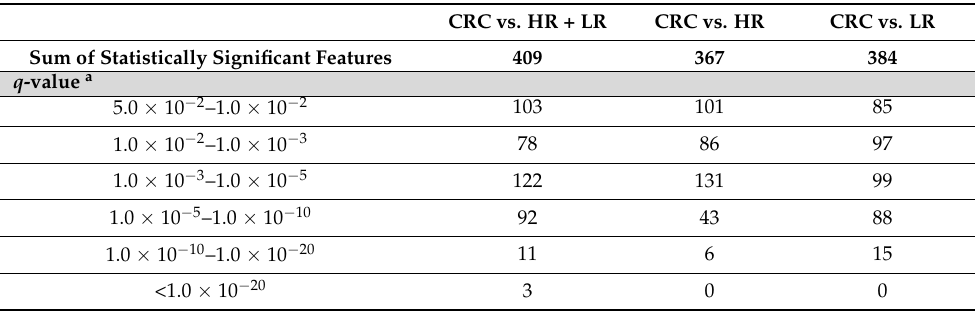
Table 2. Quantification of FDR-adjusted p -values of statistically significant metabolic features within the three comparison